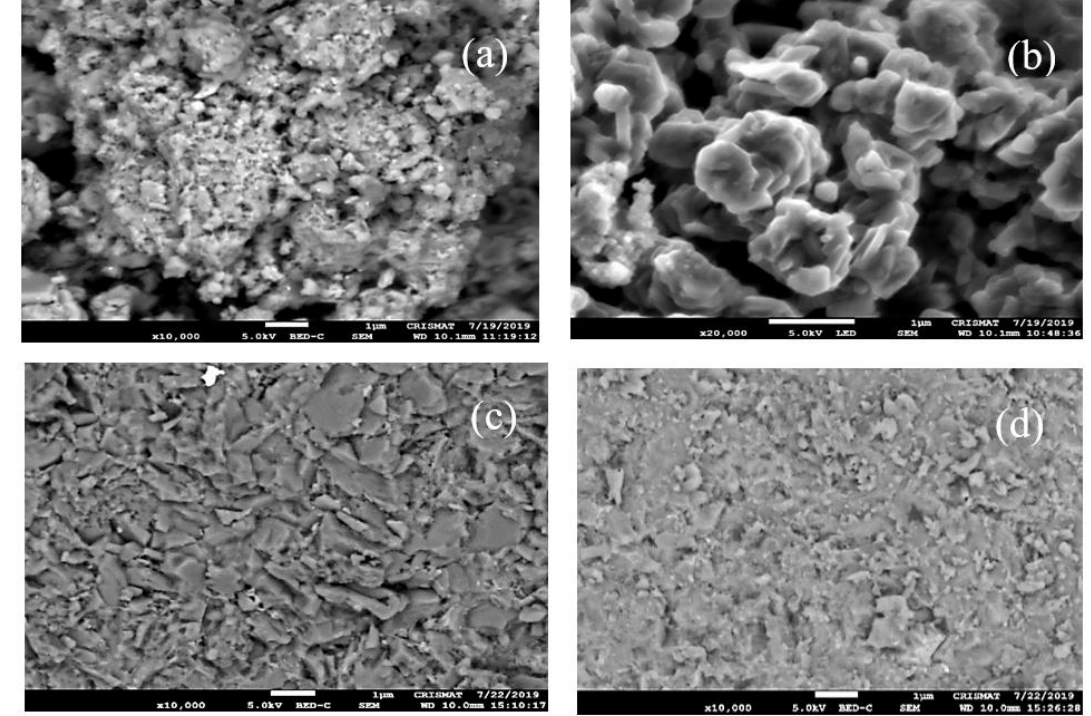
Figure 3. Microstructural evolution of sintered ceramics by conventional SPS at 950 °C at ( a ) 50 MPa, ( b ) 100 MPa, and by HP-SPS at ( c ) 800 °C, 3 GPa and ( d ) 950 °C, 5 GPa.